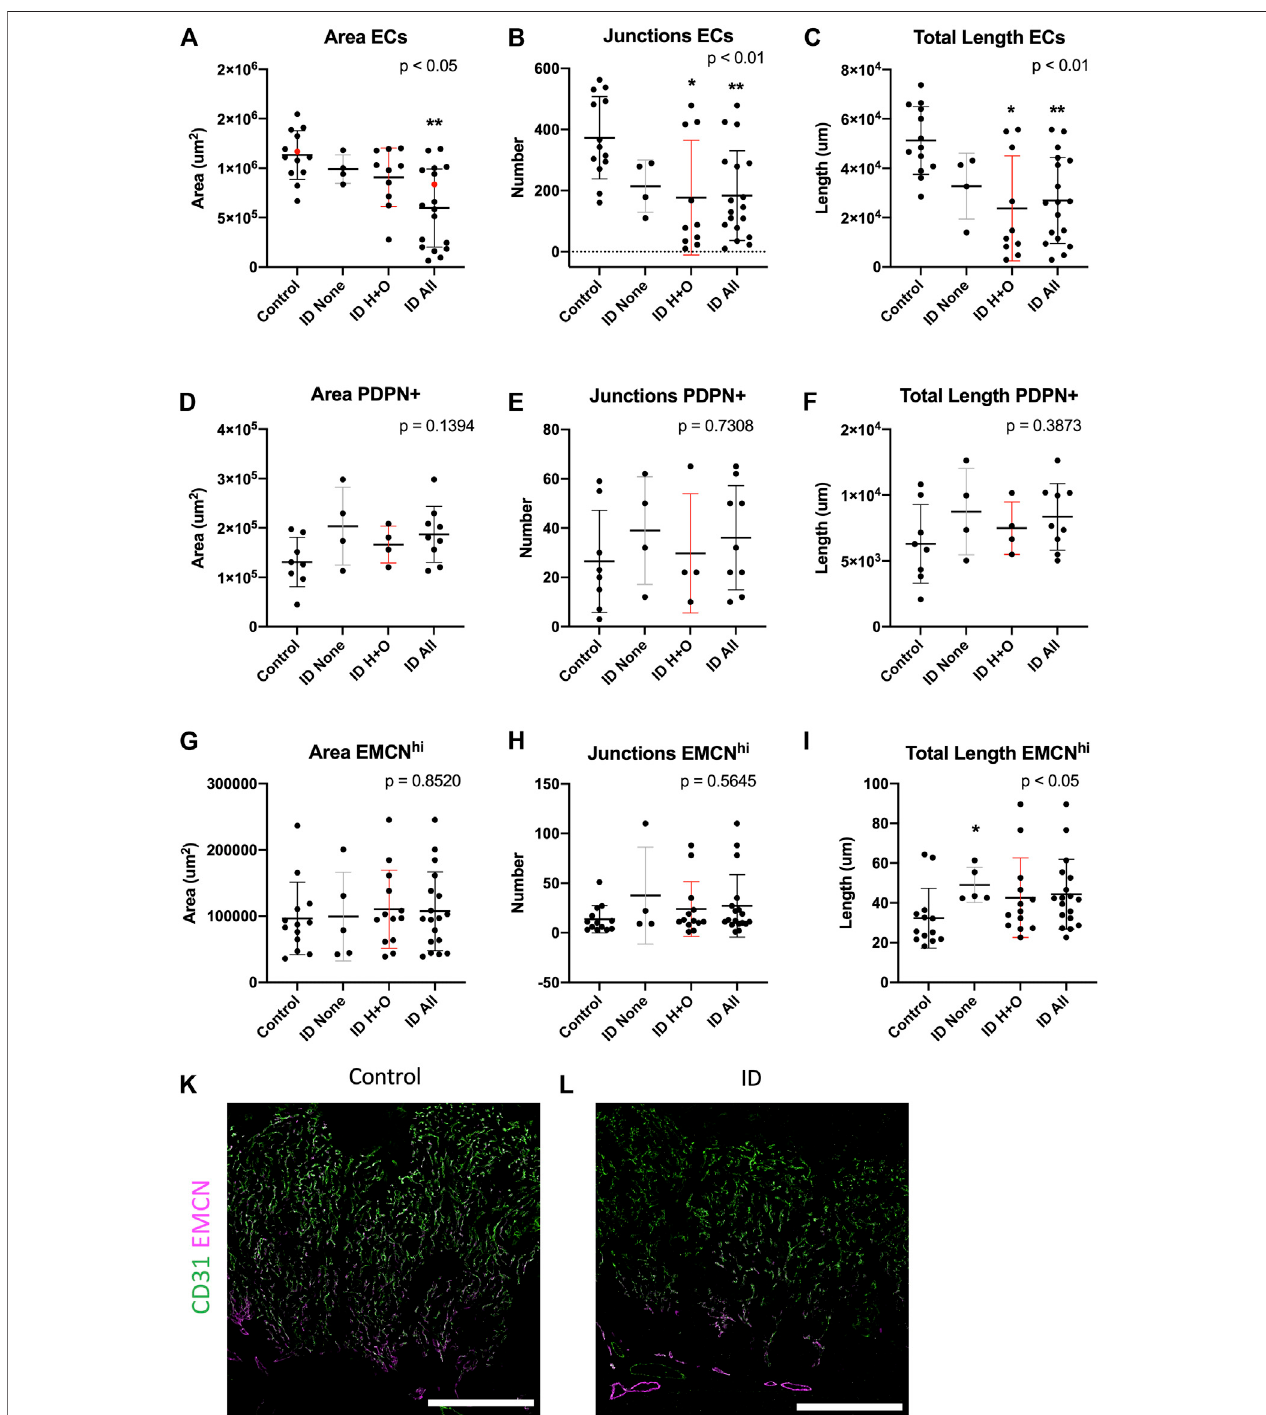
FIGURE3| Maternalironde fi ciencyreducestotalbutnotvenous-speci fi cECsintheE15.5placenta.TotalECs (A – C) ,PDPN+ECs (D – F) ,andveins(EMCN hi ) (G – I) wereassessedforvesselarea,numberofjunctions,andtotallength.IDsampleswerestrati fi edforthosewithheartdefectsandoedema(IDH+O)orthosewithnone(ID none).Redpointsin(A)correspondtoplacentalimagesin(K,control)and(L,ID),showingCD31(pan-EC)andthresholdedEMCNtohighlightstrongvenousexpression. IHC wasperformedforCD31 and EMCN.Datarepresentedasmean ± SD. Datawereanalyzed byordinaryone-wayANOVA ifnormallydistributed (D – F) or, ifnot, by Kruskal – Wallis test (A – C,G – I) . Post-hoc analysis was compared to the control group; * p < 0.05 and ** p < 0.01. Control, n (cid:1) 13 (A – C, G – I) and 8 (D – F) . ID, n (cid:1) 18 (A – C, G – I) and 9 (D – F) . ID, iron de fi cient. Scale bars (white) (cid:1) 200 um.